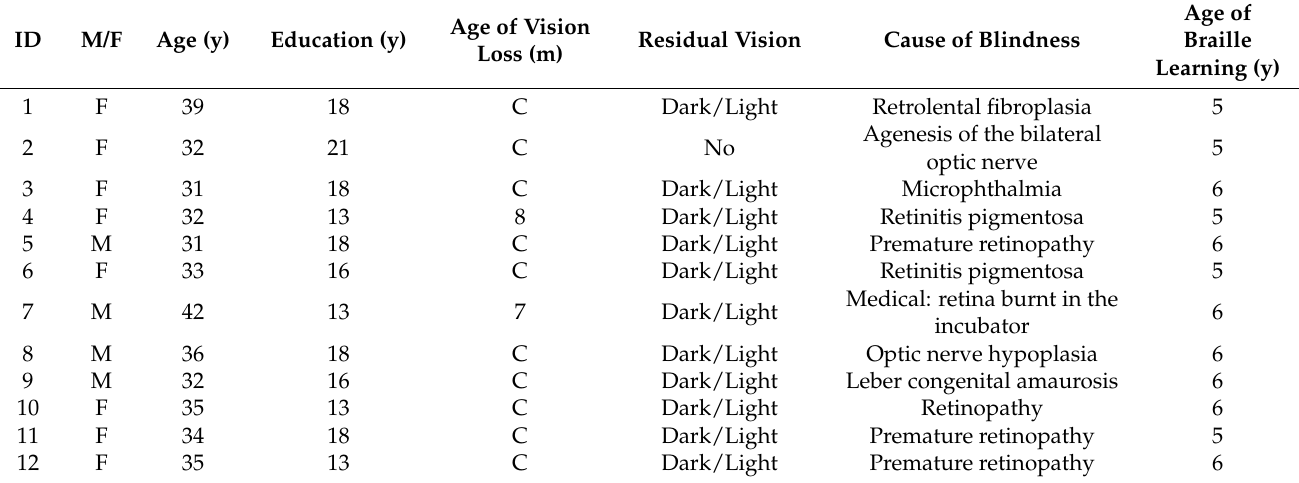
Table 1. Demographical and clinical features of blind participants. “M” = male; “F” = female; “y” = years; “m” = month; “C” =